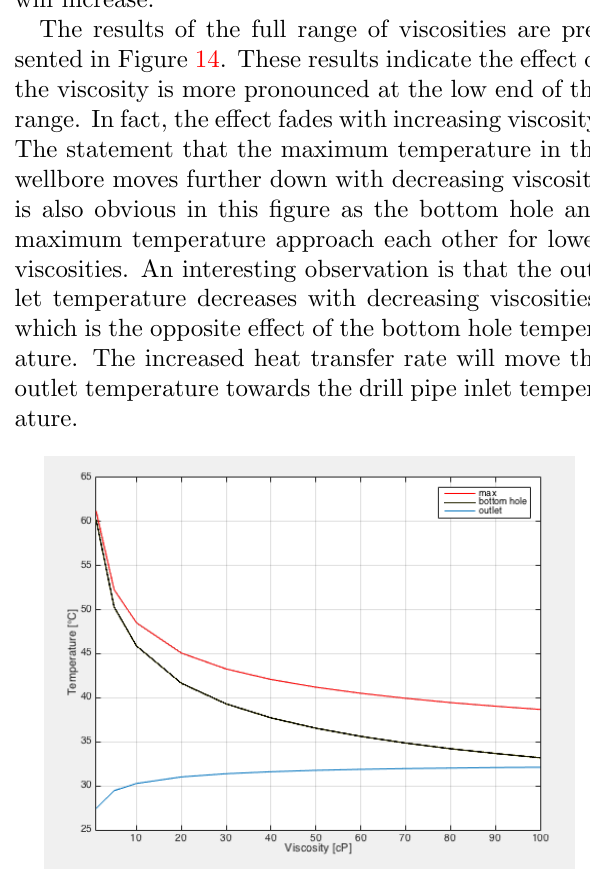
Figure 14: Temperature vs.